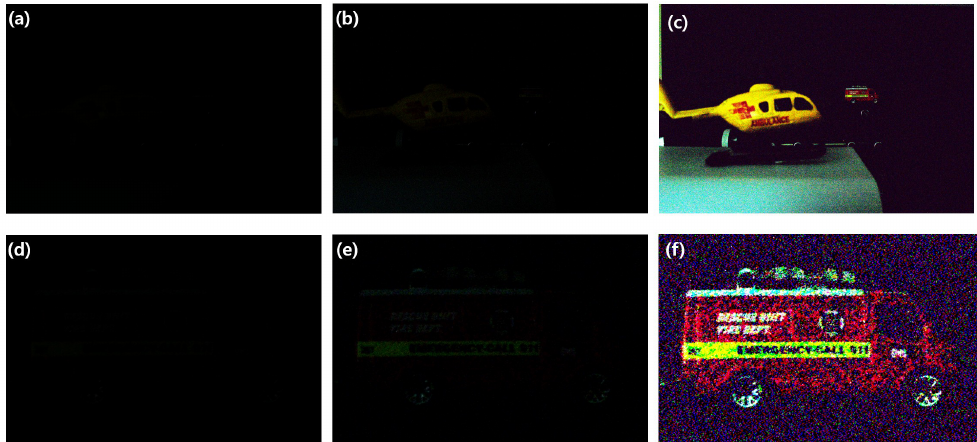
Figure 7. ( a ) 13th elemental image and ( b ) new elemental image for ROI of ( a ).